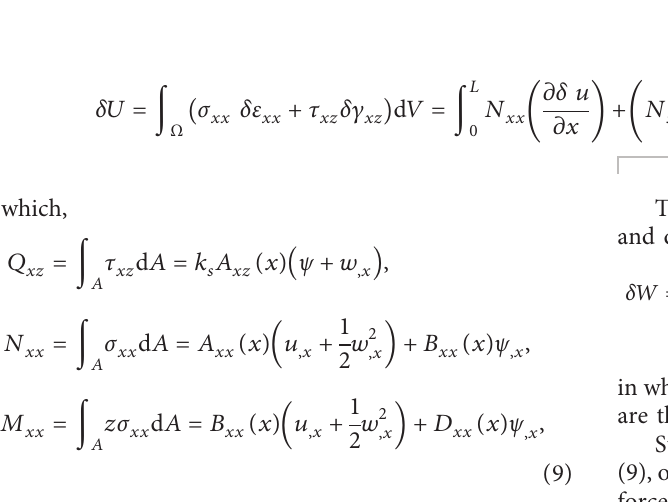
Figure 1: The coordinate system and geometrical notation BDFG porous